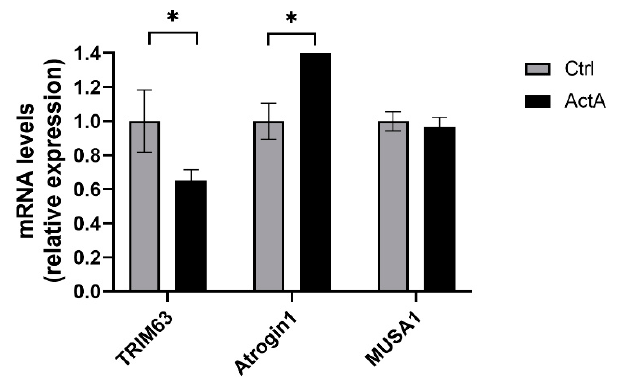
Figure 5. The activin A-induced myotube atrophy is not associated with an increase in classical E3 ubiquitin ligases. TRIM63 , Atrogin1 , and MUSA1 mRNA levels measured by RT-qPCR, 48 h after exposure to recombinant ActA or vehicle. Data are reported as means ± SEM (n = 3/condition). * p < 0.05 vs. Ctrl.